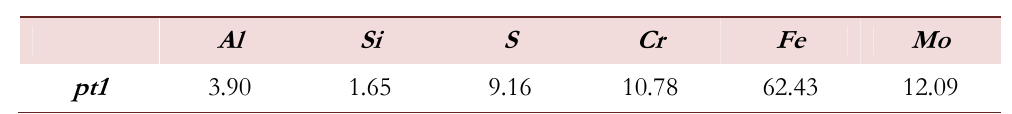
Table 1: EDS analysis (weight%) of areas shown in the Fig. 12.